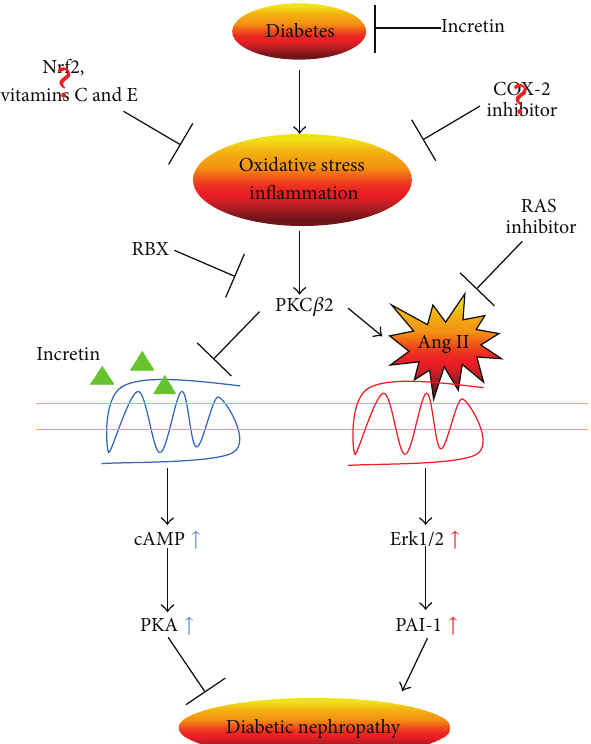
Figure 3: Schematic representation of potential protective factors, including incretin and biological targets of PKC activation that couldpreventtheprogressiontodiabeticnephropathy.Nrf2,nuclear factor erythroid 2-related factor 2; COX-2, cyclooxygenase-2; RAS, renin angiotensin system; RBX, ruboxistaurin; PKC, protein kinase C; Ang II, angiotensin II; cAMP, cyclic adenosine monophosphate; Erk, extracellular signal-regulated kinase; PKA, protein kinase A; PAI-1, plasminogen activator